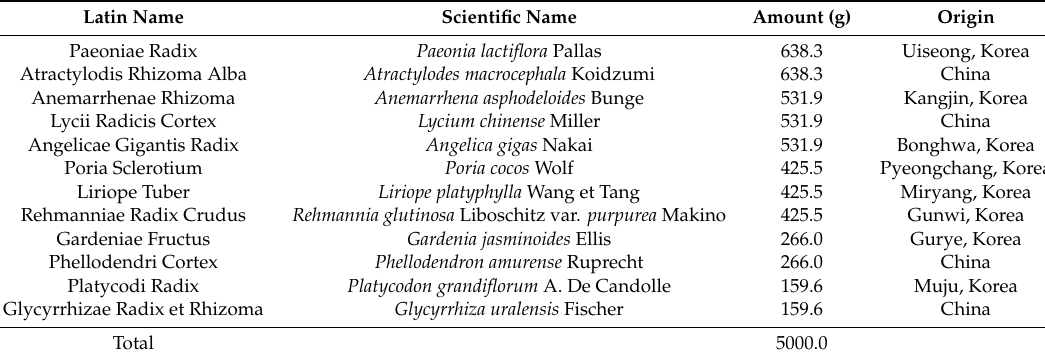
Table 1. Composition of